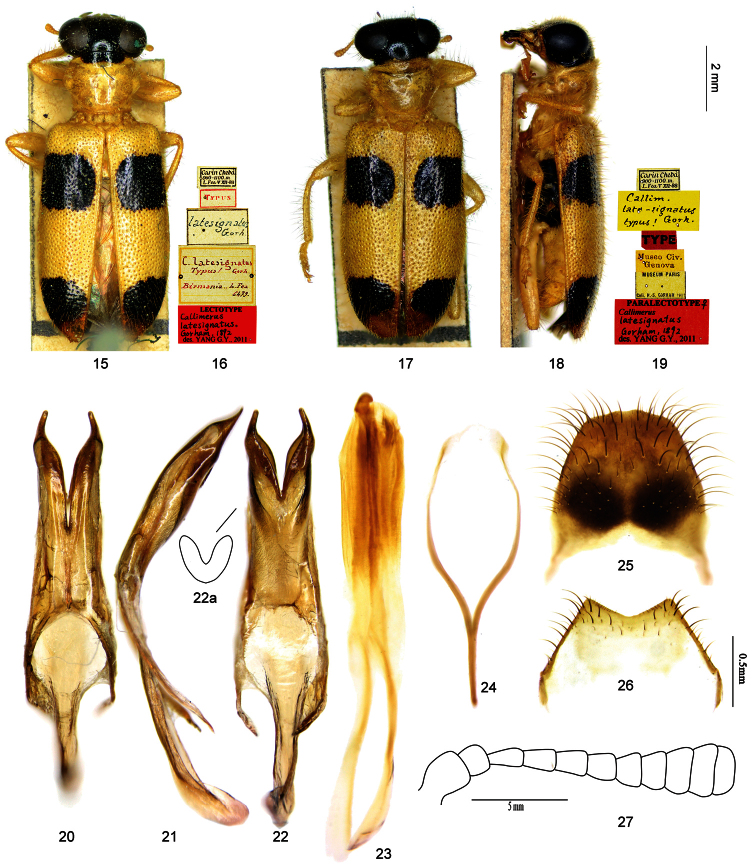
Callimerus latesignatus Gorham, 1892. 15–16 lectotype of Callimerus latesignatus Gorham, 1892 (15 dorsal view 16 labels) 17–19 Paralectotype of Callimerus latesignatus Gorham, 1892 from MNHN (17 dorsal view 18 lateral view 19 labels) 20–26 male terminalia, specimen from Yunnan 20–22 tegmen (20 dorsal view 21 lateral view 22 ventral view 22a outline of ventral membranous region) 23 phallus 24 spicular fork 25 tergite VIII 26 sternite VIII 27 antenna, specimen from Yunnan.